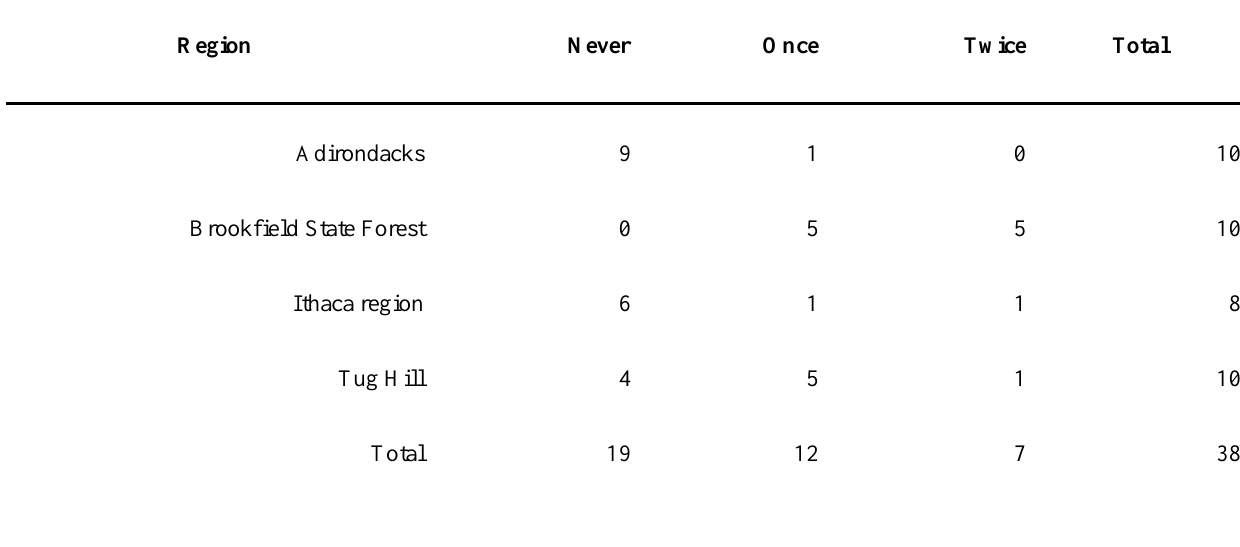
Table 1. Detections of Wood Thrushes by region. Each site was visited twice, according to the Birds of Forested Landscapes (BFL) protocol. Distribution of number of detections in each category differed significantly between regions, Fishers exact test c 2 = 22.73, df = 6, P = 0.0014.